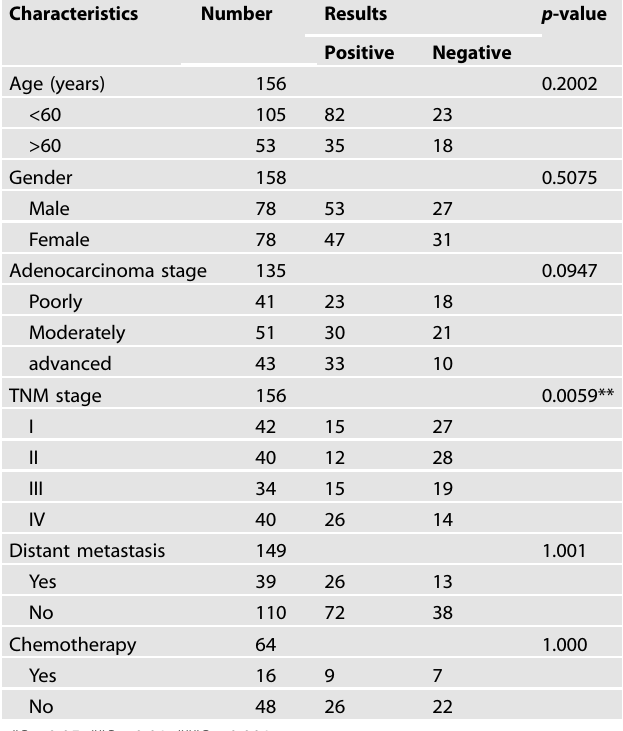
Table 1. Clinical characteristics of the 158 NSCLC